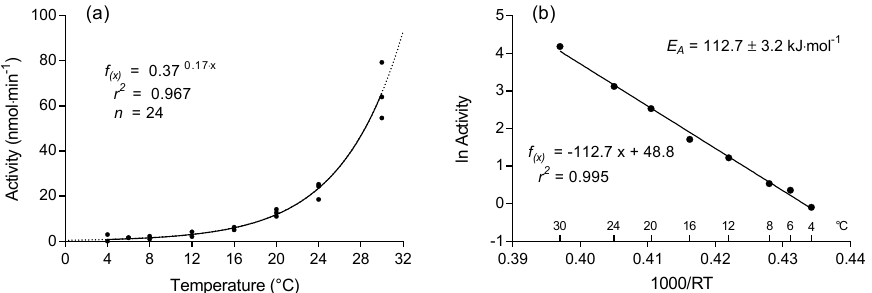
Figure 7. ( a ) Hydrolysis rates of PLA at different temperatures. ( b ) Arrhenius-plot calculated from data of the temperature profile of PLA hydrolysis.